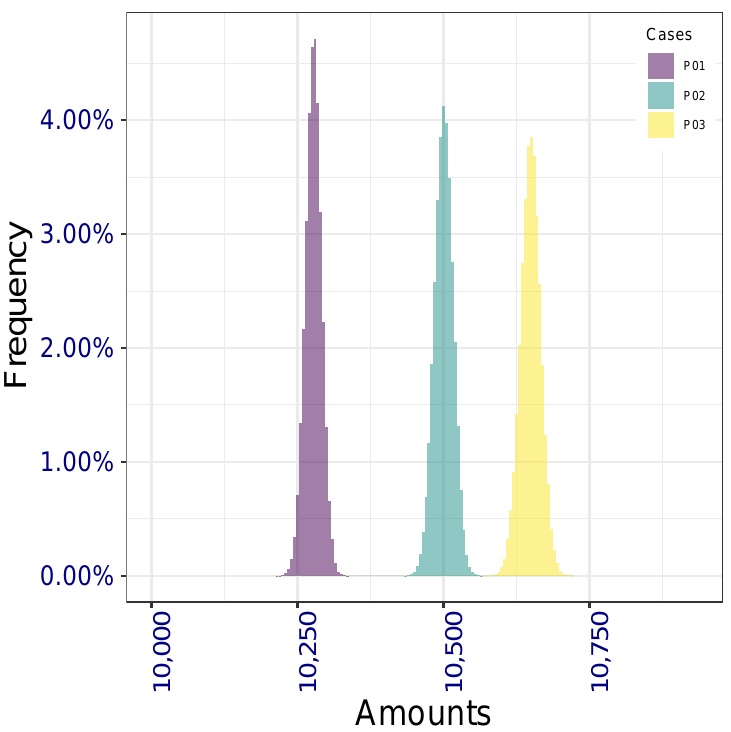
Figure 5. Impact of cannibalization effect: empirical distributions of the annual benefit payout at time t =